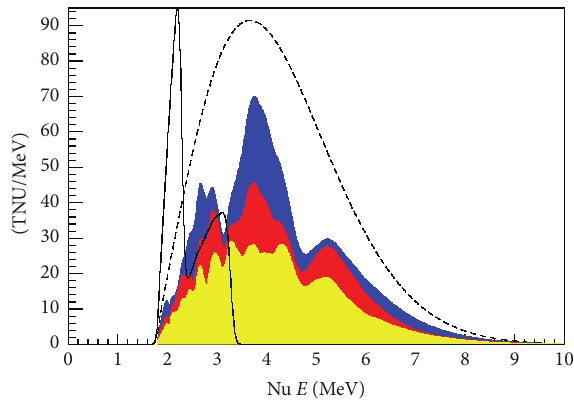
Figure 8: Expected visible antineutrino energy spectrum in SNO+, for 10 32 proton-years per MeV. The nonoscillated reactor spectrum (dashed line) is shown together with the geoneutrino spectrum (solid line, arbitrary normalisation). The stacked oscillated reactor spectrum is shown with different colors, each corresponding to a reactor complex: reactor at 240 km in blue (top), reactors at 350 km in red (middle), and other reactors in yellow (bottom). See text for